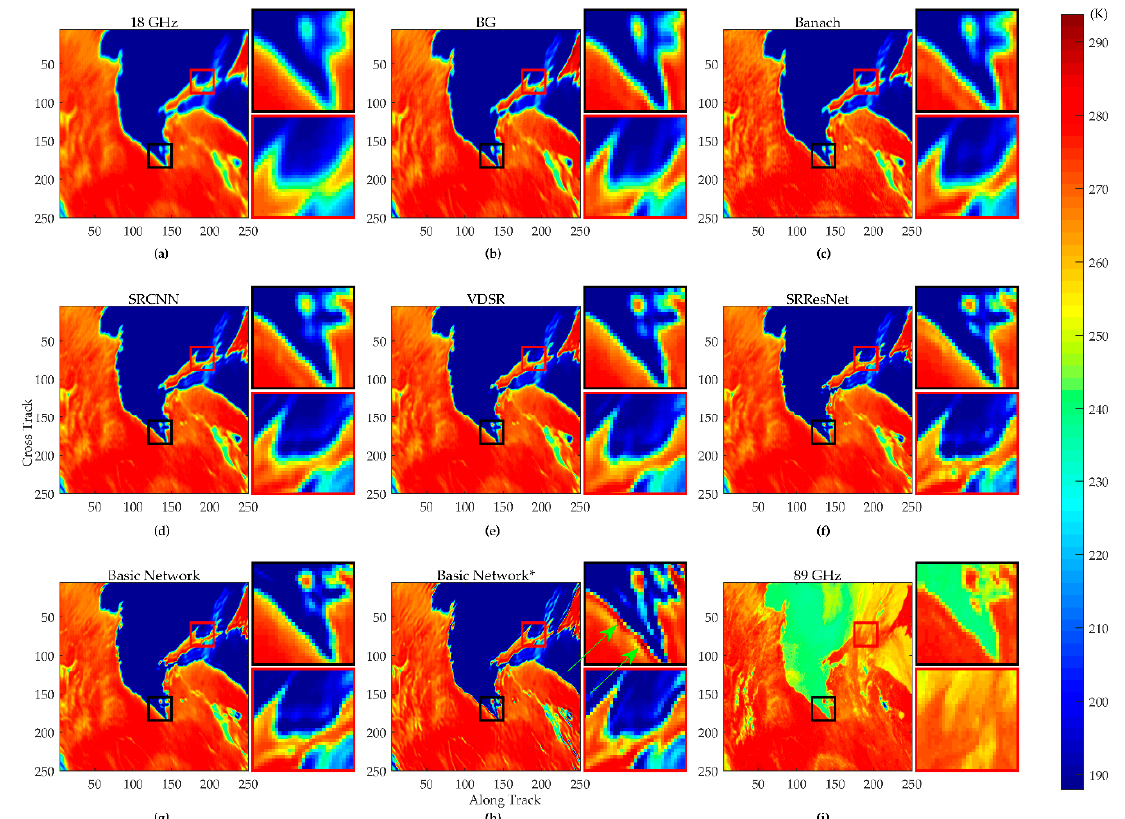
Figure 11. Resolution match results of real 18.7 GHz MWRI data. (a) Real 18.7 GHz antenna temperature image; (b) Match result of the BG method; (c) Match result of the Banach method; (d) Match result of SRCNN; (e) Match result of VDSR; (f) Match result of SRResNet; (g) Match result of basic network N b ; (h) Match result of basic network N b with degradation model (Equations (10) and (11)); (i) Real 89 GHz antenna temperature image.